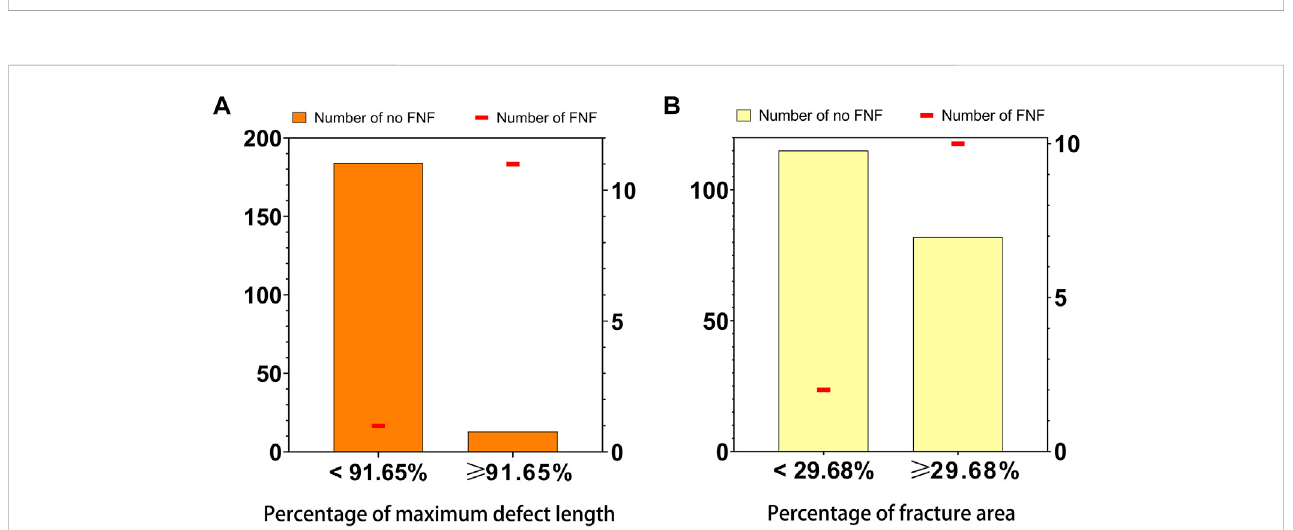
FIGURE 4 Distribution of 2D parameter (A) , the average percentage of maximum defect length across three planes, and 3D parameter (B) , the percentage of fracture area, and the number of the femoral neck fracture in the 209 patients with femoral head fractures. Numbers were indicated [femoral head fracture with (line in red) or without (bar in orange or yellow) femoral neck fracture] in the relevant